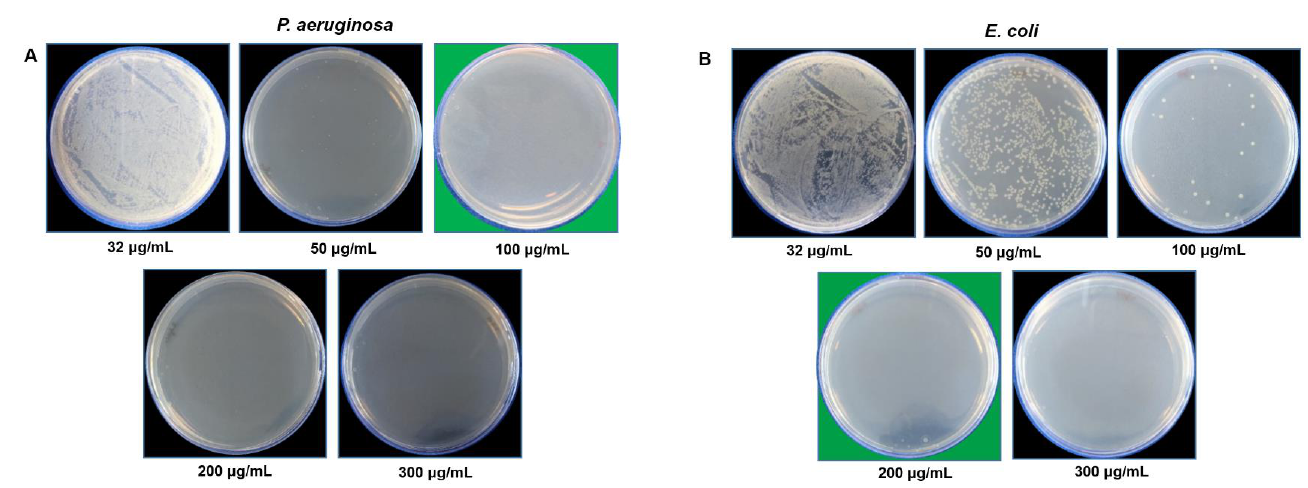
Figure 8. Cell viability test at different concentrations range from 32 to 300 µg/mL of RB-AgNPs for ( A ) P. aeruginosa and ( B ) E. coli . The green background shows the MBC values of respective pathogens with complete growth inhibition.